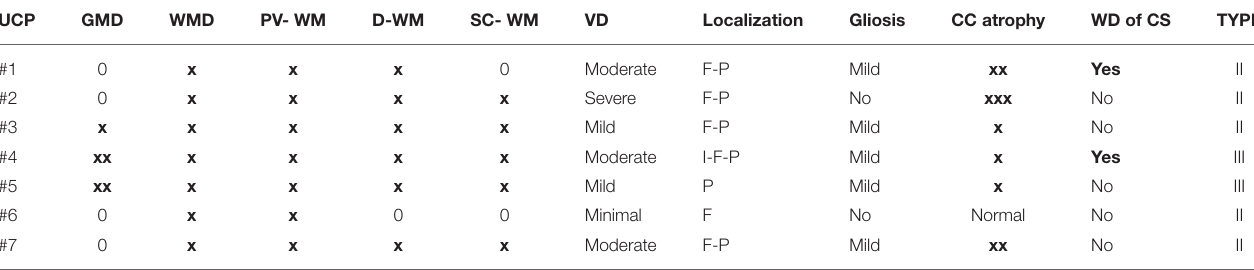
TABLE 2 | Neuroradiological findings and anatomical characteristics of lesions in cases group.